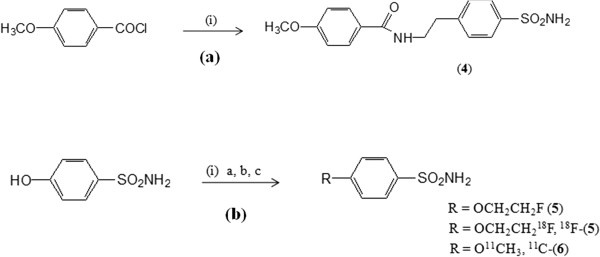
Synthesis of [18F]-(5) and [11C]-(6). Reagents and conditions: (a) (i) AEBS, dichloromethane, pyridine for 72 h at room temperature. (b) (i) (a) DMF, 1-bromo-2-fluoroethane, 70°C, 16 h; (b) DMF, NaOH 1 M, 11CH3I, 90°C, 15 min; (c) DMF, NaOH 1 M, 18FEtBr, 90°C, 15 min.